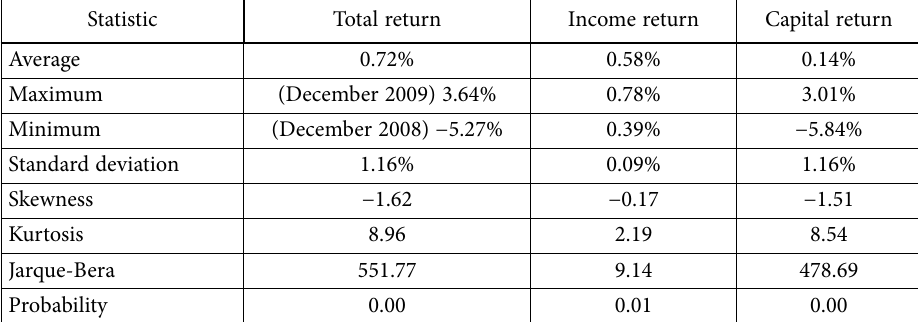
Table 1. Summary statistics